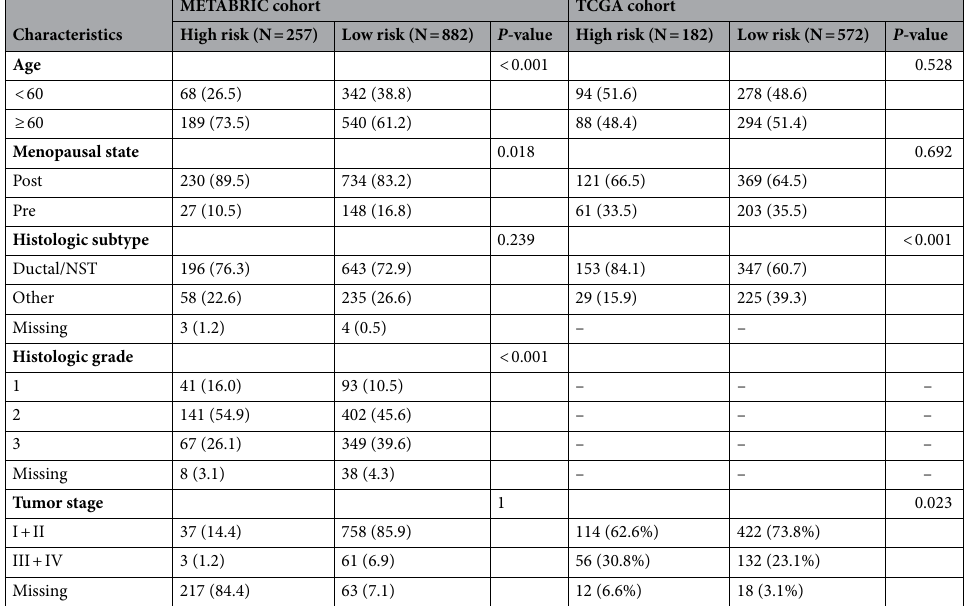
Table 2. Baseline characteristics of the patients in different risk